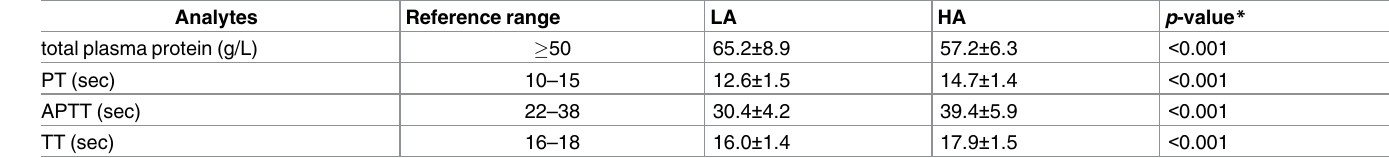
Table 3. The total plasma protein content and basic coagulation tests results of different altitude blood donors. §